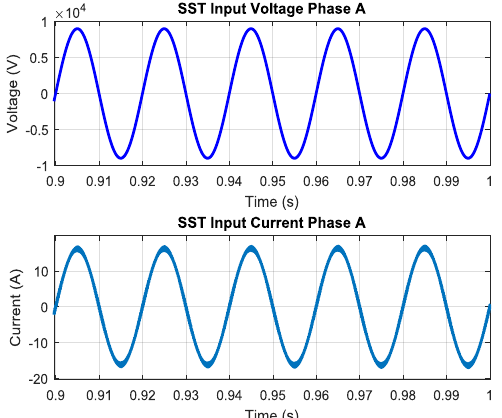
Figure 14. SST output current to the unbalanced load.